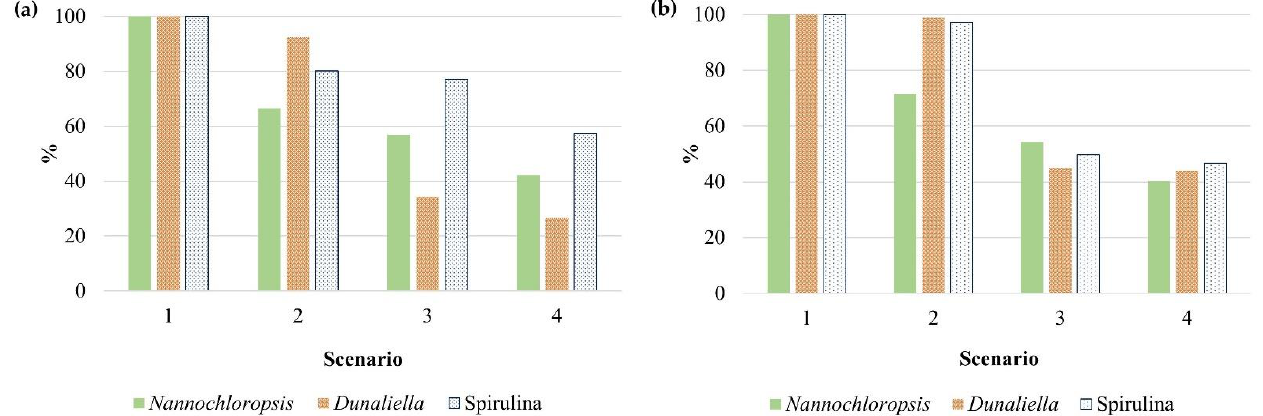
Figure 3. Variations in ( a ) climate change and ( b ) freshwater toxicity impact categories in all scenarios, for the three assessed strains, in comparison to the base-case Scenario 1.